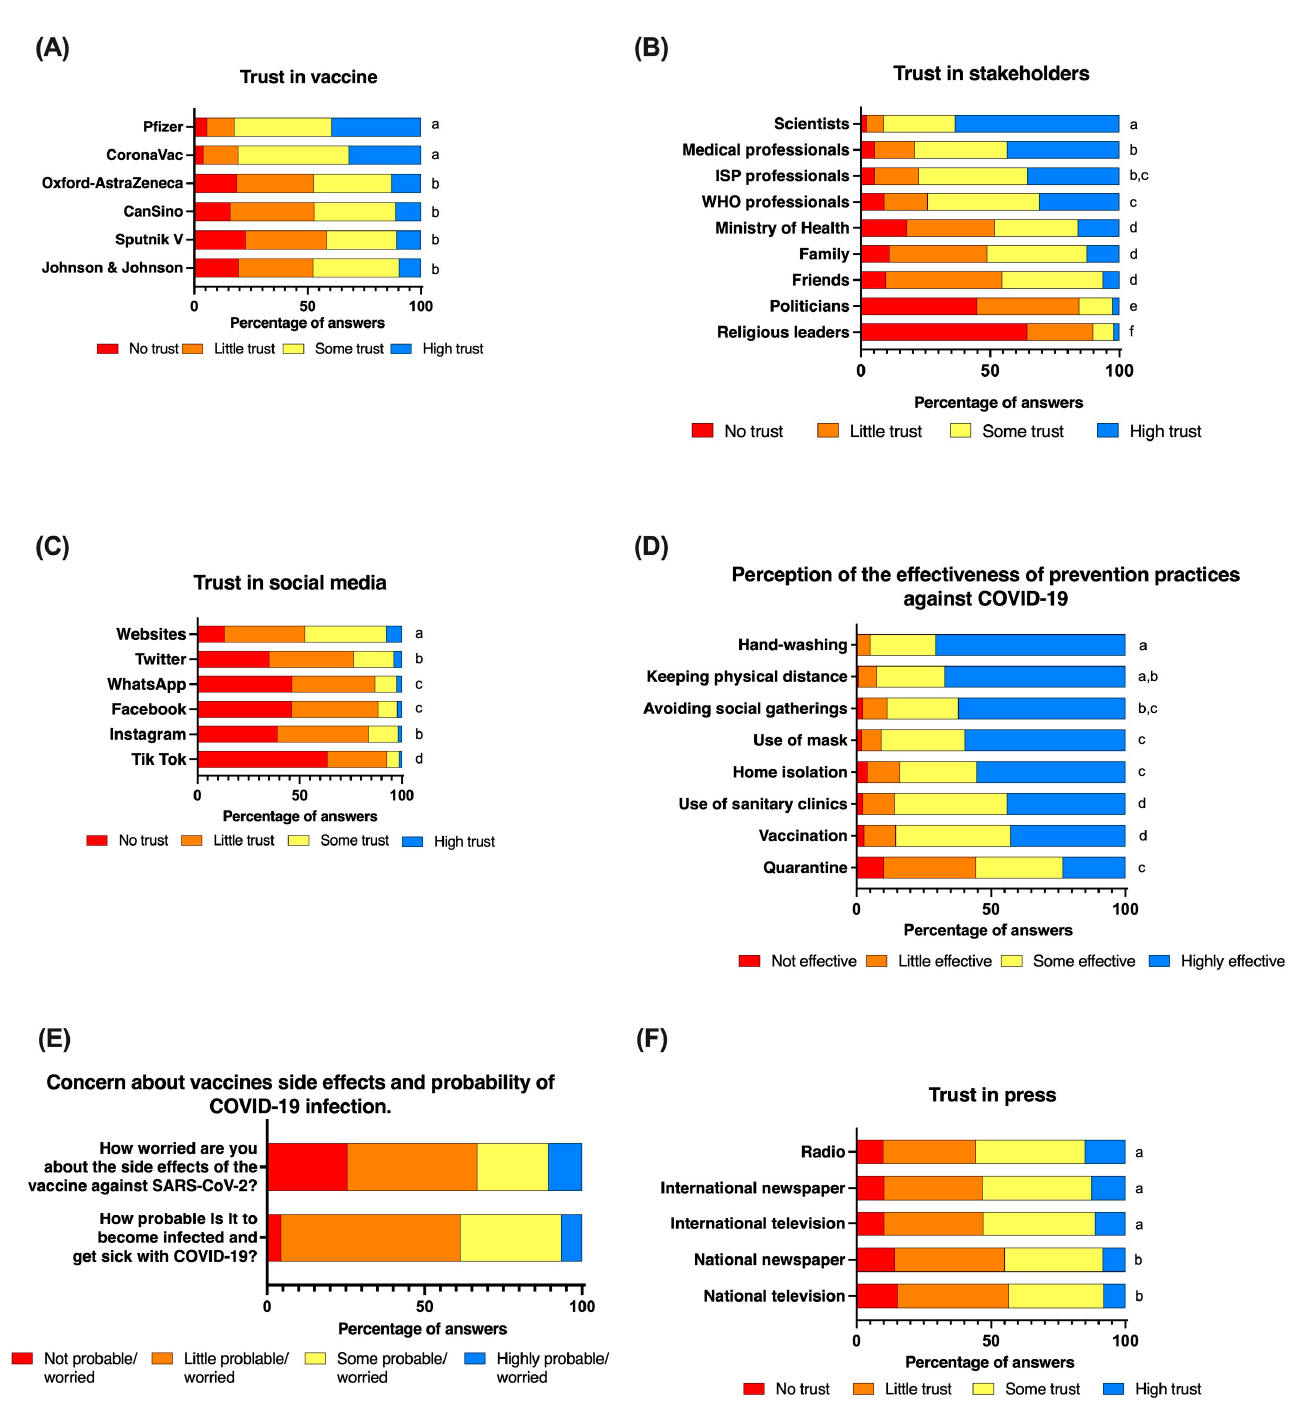
Figure 1. Respondents’ perceptions of vaccine side effects, getting sick from COVID-19, effectiveness of COVID-19 control practices, and trust in vaccines, stakeholders, social media, and the press ( n = 744). The bars indicate the breakdown of the percentage of respondents providing an answer to each question asked. The full questionnaire is shown in the Supplementary Information. ISP (Chilean Public Health Institute), WHO (World Health Organization). ( A ) Trust in vaccine. ( B ) Trust in stakeholders. ( C ) Trust in social media. ( D ) Perception of the effectiveness of prevention practices against COVID-19. ( E ) Concern about vaccines’ side effects and probability of COVID-19 infection. ( F ) Trust in the press. For all figures, different lowercase letters indicate a significant difference of trust or perception (Dunn’s test with Bonferroni adjustment, p < 0.01).